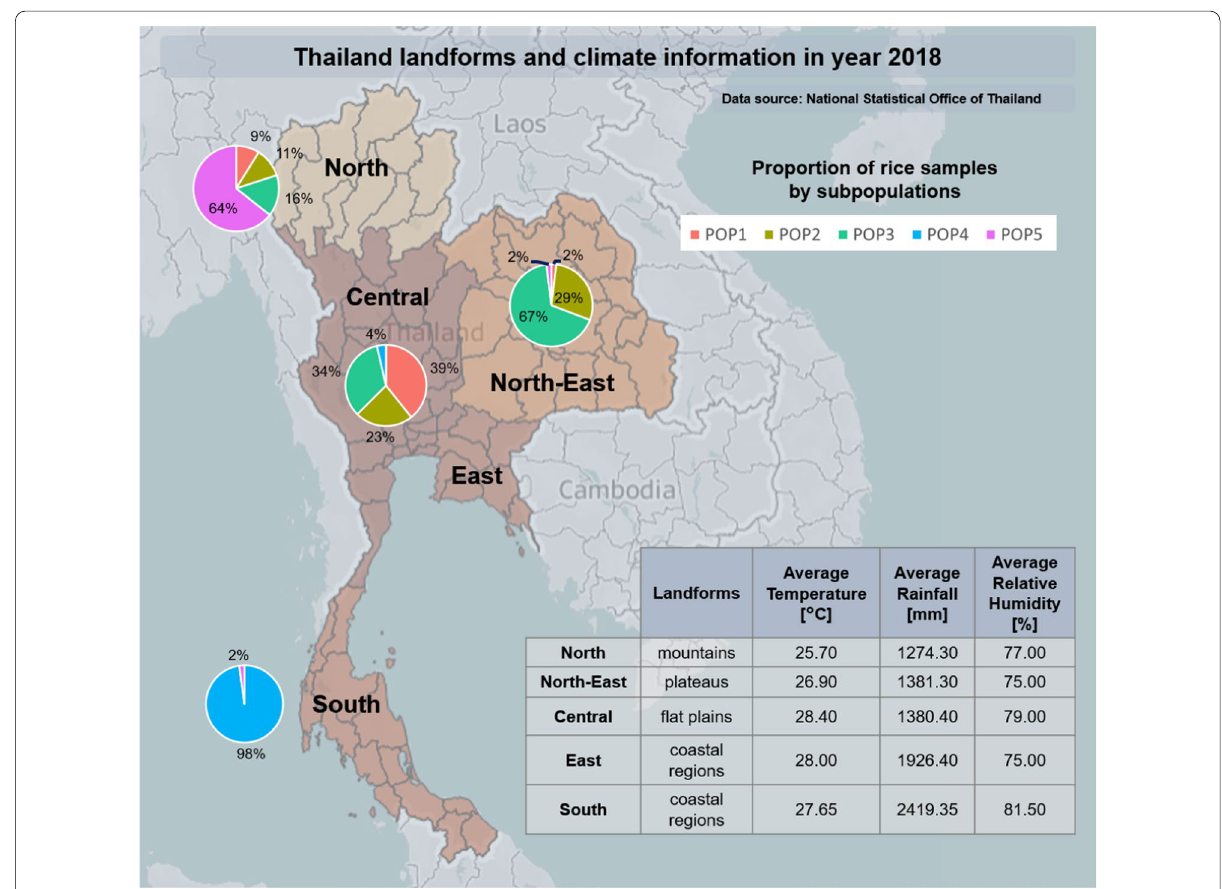
Fig. 1 The environment of Thailand and the ratios of subpopulations in each area. The environment details are in the aspects of landforms, average temperature, amount of rain, and humidity in 2018 separated by regions (National statistical office of Thailand (NSO and T.N.S.O. 2020)). Each pie chart represents the ratio of each subpopulation members that have their known origin belong to the particular area. Note that there are no accessions for the east since it is not a rice cultivation